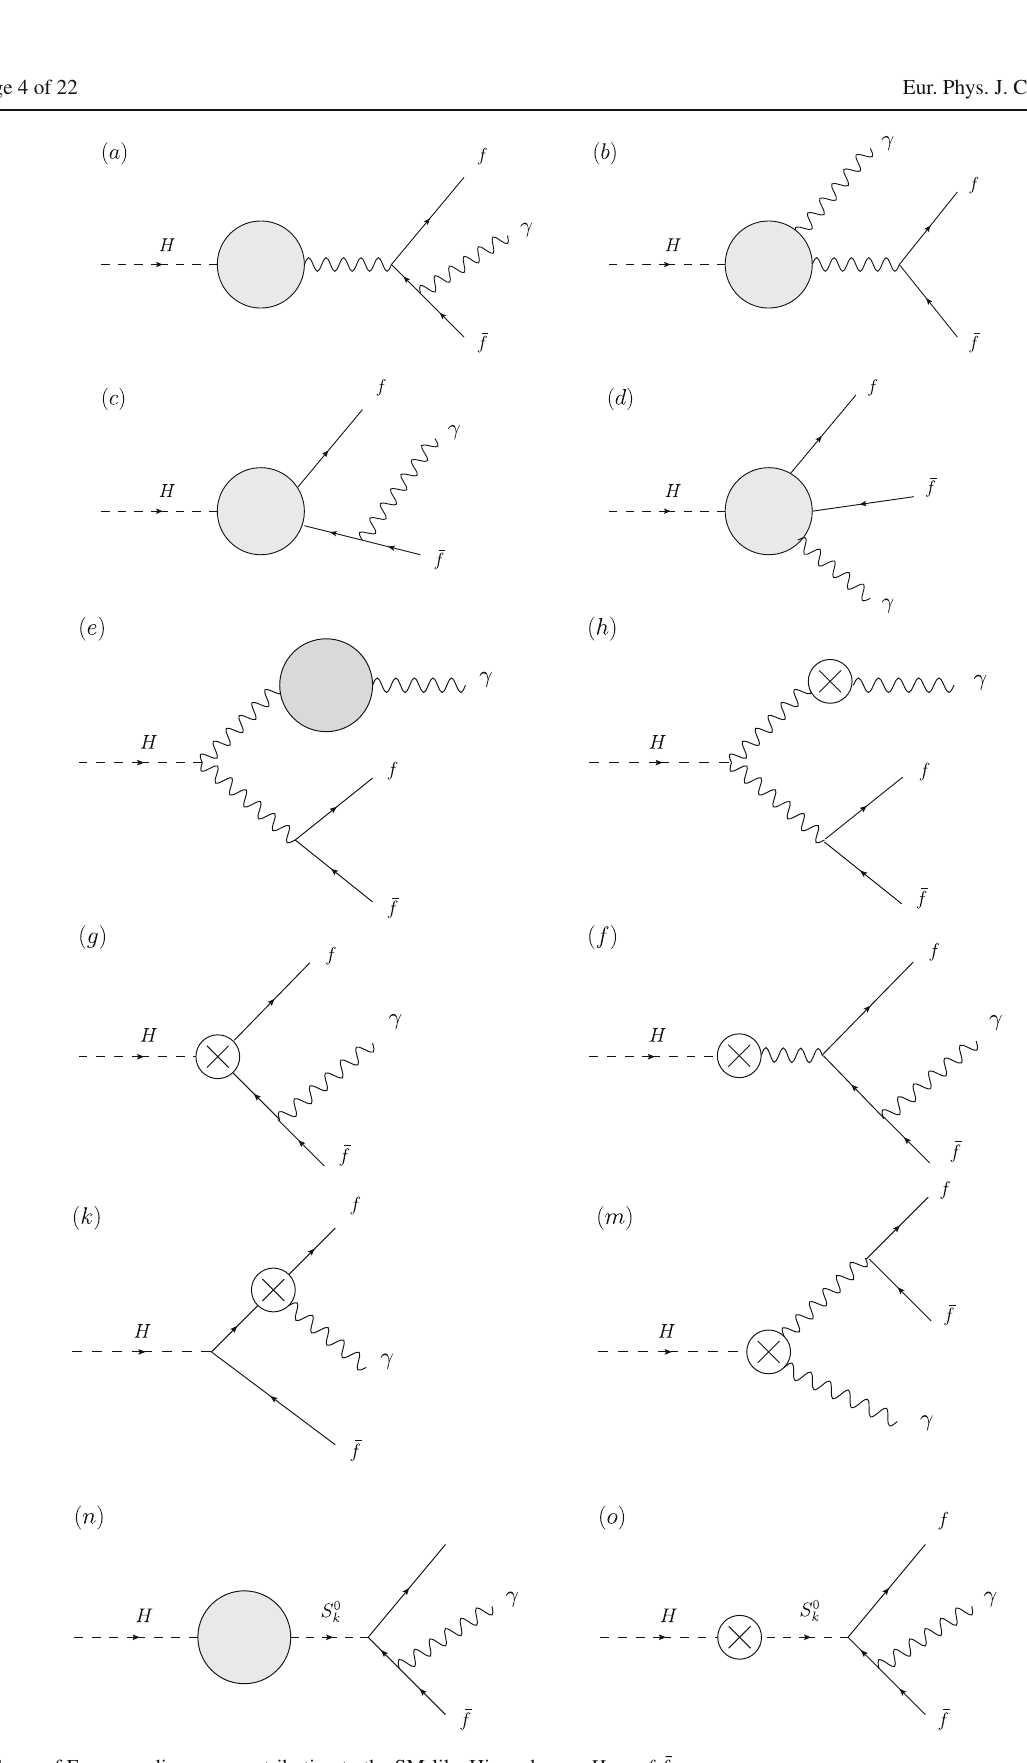
Fig. 1 Types of Feynman diagrams contributing to the SM-like Higgs decays H → f ¯ f